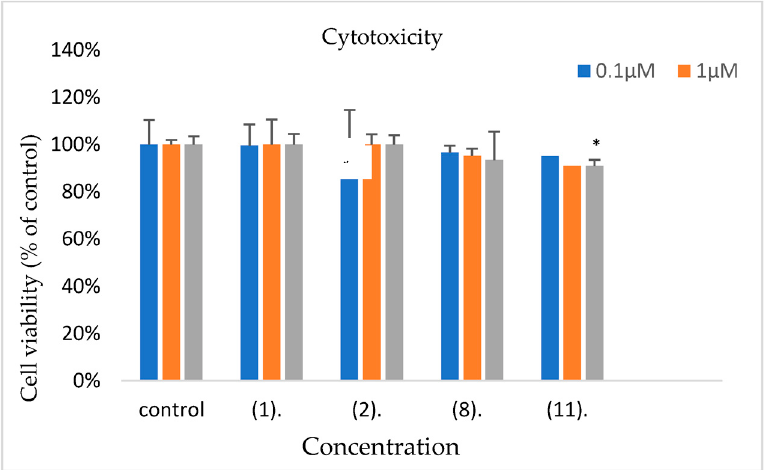
Figure 10. Cell viability levels (%) of MRC-5 cells exposed for 48h at various concentrations in culture to compounds 1 , 2 , 8 , and 11 . All values are presented as mean ± standard deviation (SD) of triplicate independent cellular experiments. With asterisk (*), the significant differences between each concentration and the control group are presented. The significance level was determined at p < 0.05.